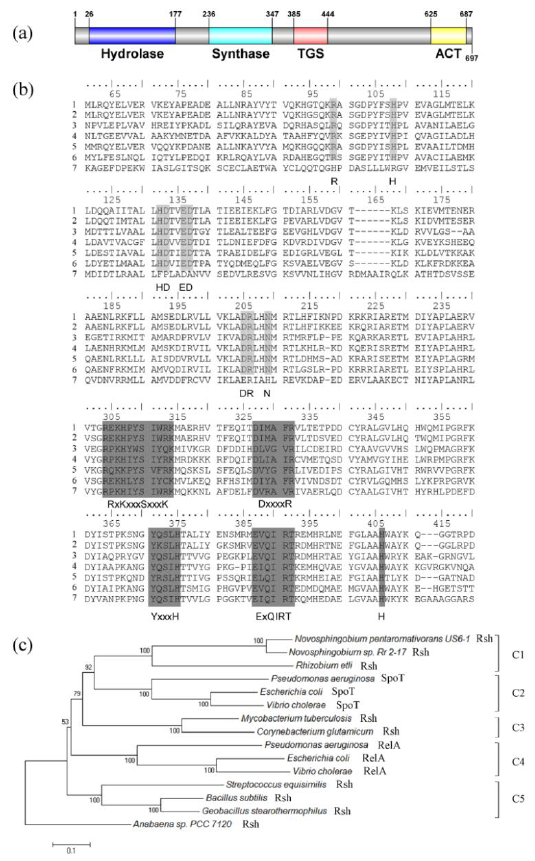
Figure 1. Sequence analysis of Rsh US6–1 protein. ( a ) Rsh US6–1 domain; ( b ) amino acid alignment of RelA/SpoT homologs. Line 1: Rsh US6–1 . Line 2: Rsh Rr2–17 . Line 3: Rsh Mtb . Line 4: Rsh Seq . Line 5: Rsh Ret .